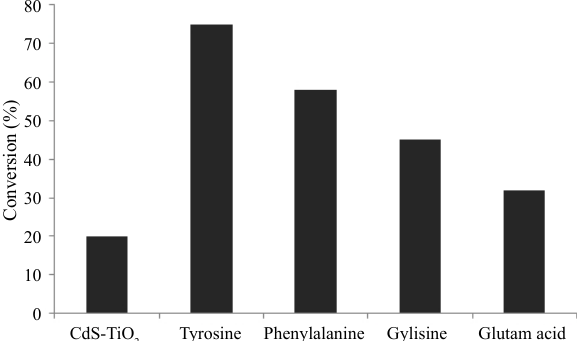
Fig. 9. The effect of opted amino acid for surface modification on the NB conversion (%) (catalyst: 0.1 g, NB: 0.0136 M, irradiation time: 120 min, pH: netural).